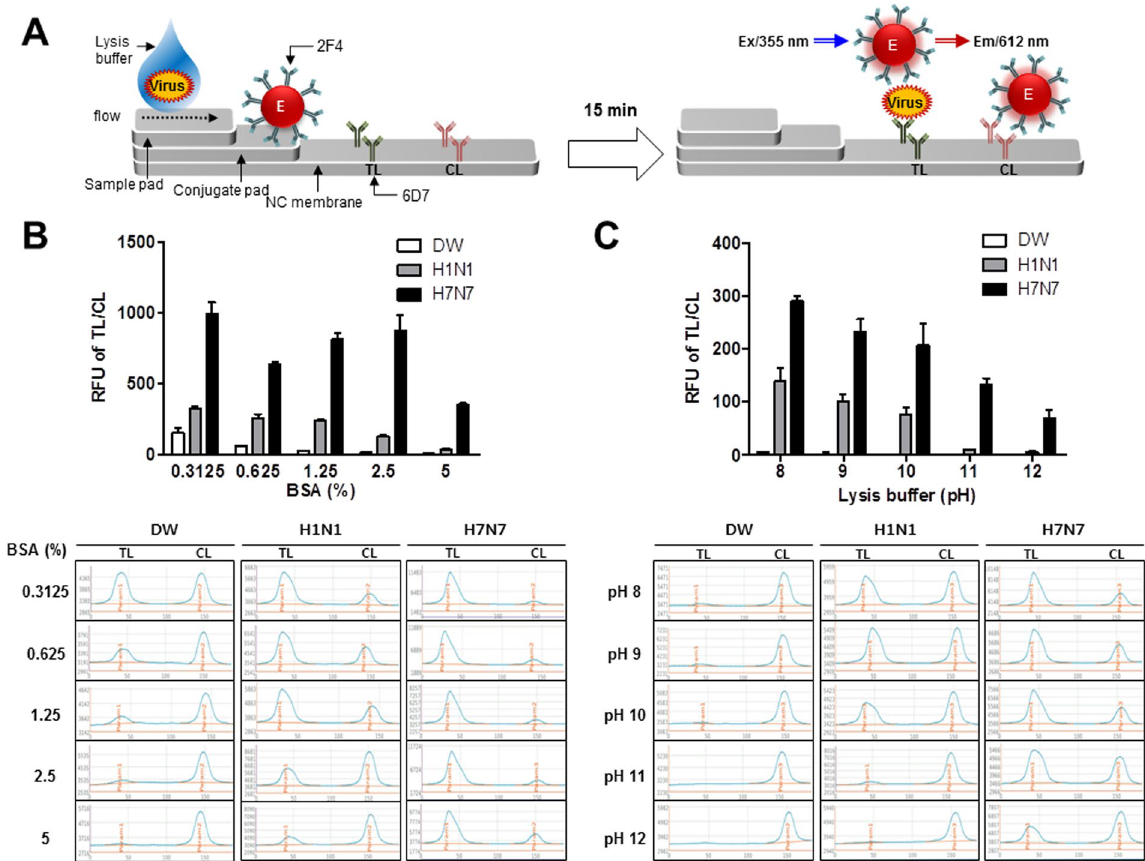
Figure 4. Optimization of FICT assay. Schematic diagram rapid fluorescence diagnostic system employing Europium-conjugated H7 subtype specific antibody was shown ( A ). 6D7 mAb was coated in the test line (TL) on NC membrane. Virus was pretreated with lysis buffer and Europium-conjugated antibody (2F4) was dropped onto the conjugate pad on the strip. Subsequently, sample was applied to the sample pad and after 15 min, the strip was used to detect the fluorescent light on the strip through the light emitting diode (LED)-built portable fluorescent strip reader. In the LED module, the excitation light (355 nm) was filtered by the emission filter (612 nm). To reduce nonspecific reactions of the FICT assay against H1N1 virus, different concentration of BSA was tested as a blocking agent to generate the bioconjugate ( B ). Lysis buffer was tested in different pH from 8 to 12 ( C ). All experiments were conducted in triplicate. The data are shown as mean ± SD. Raw fluorescence peaks from the test line (TL) and control line (CL) in FICT are shown in the bottom